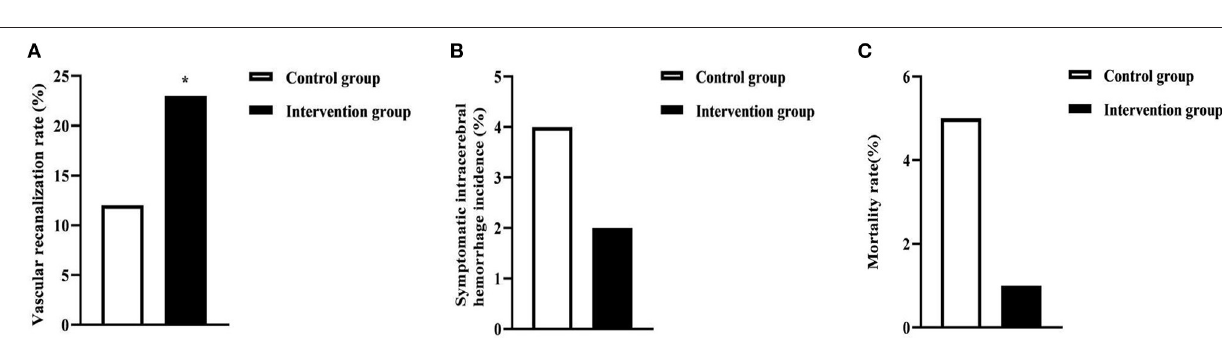
departments; The opening of the AIS emergency green channel, expedited appointments for relevant examinations, delivery of examinations and medication pickup by professionally